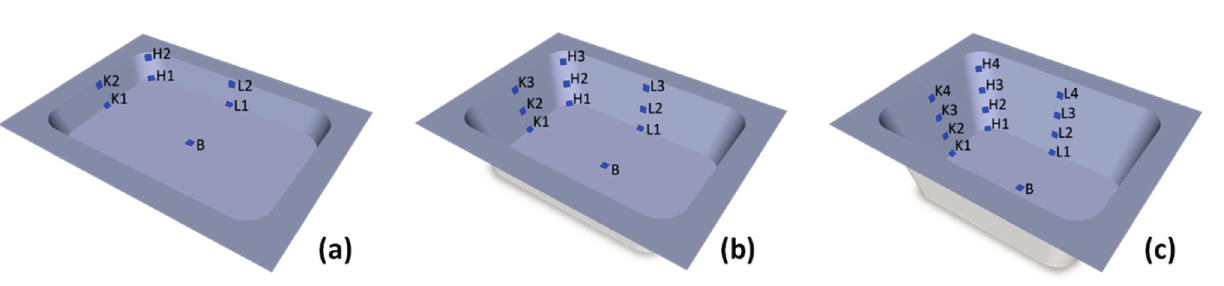
Figure 9. Locations in 25- ( a ), 50- ( b ), and 75-mm ( c ) trays that were analyzed microscopically for individual layer thickness. Locations L, K, H, and B were selected in the long side wall, short side wall, corner, and bottom,